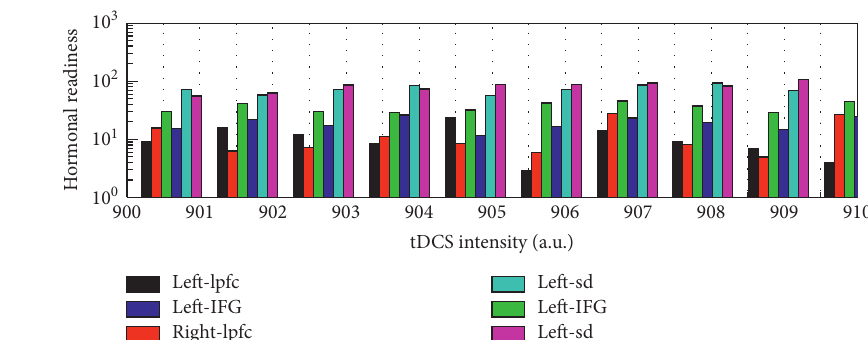
Figure 6: Account list classification of the automated user classification system.